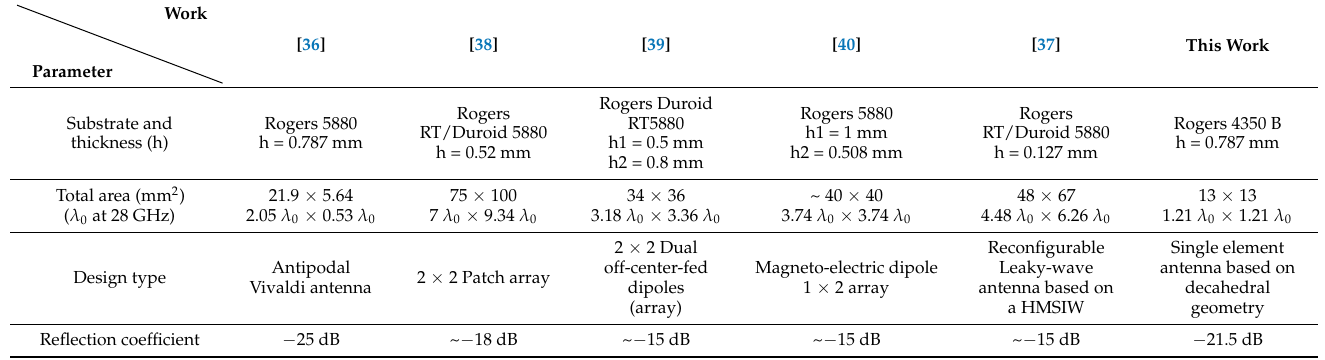
Table 1. Comparison with Related Works Operating at 28 Ghz (SISO